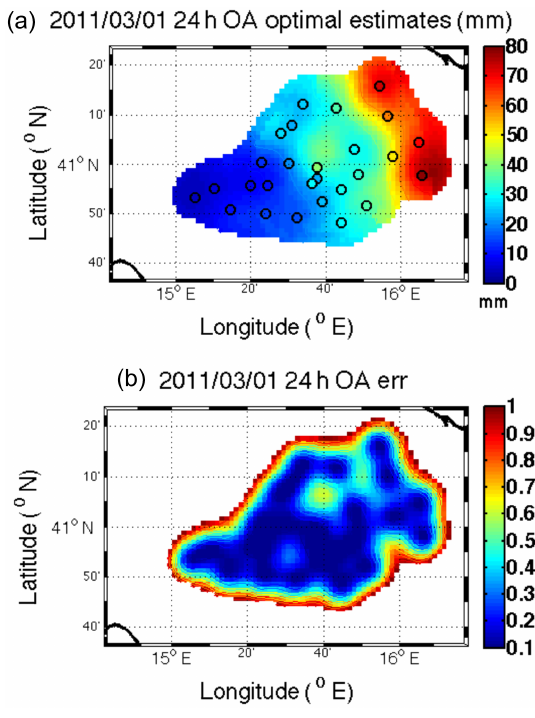
Figure B1. Mapping of daily precipitation (mmday − 1 ) on 1 March 2011 as carried out by objective analysis (OA). (a) OA optimal estimate with overlapping observations; (b) OA